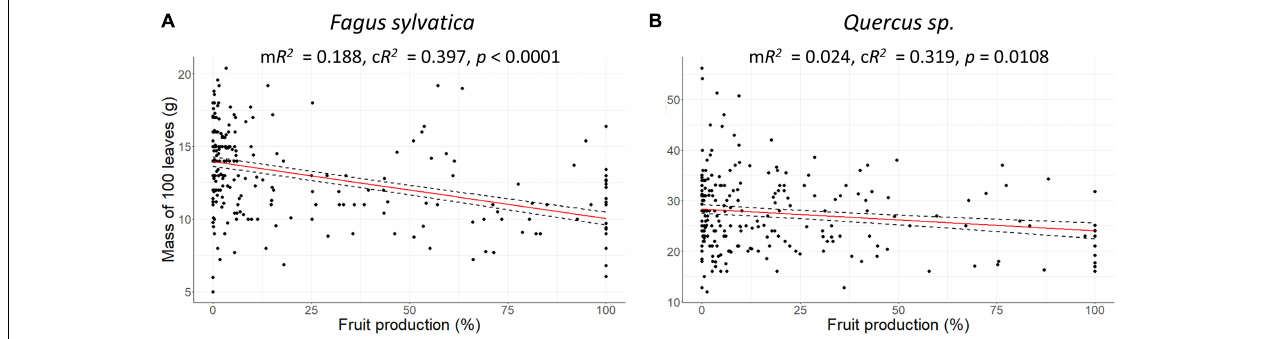
FIGURE 4 | Scatter plots of dry mass of 100 leaves (g) vs. fruit production in percentage of maximum values per plot at European scale. (A) Fagus sylvatica , (B) Quercus sp. Red line: Response curve of the linear mixed-effects modelling, dashed line: Standard errors, m R 2 : Marginal R 2 , c R 2 : Conditional R 2 .